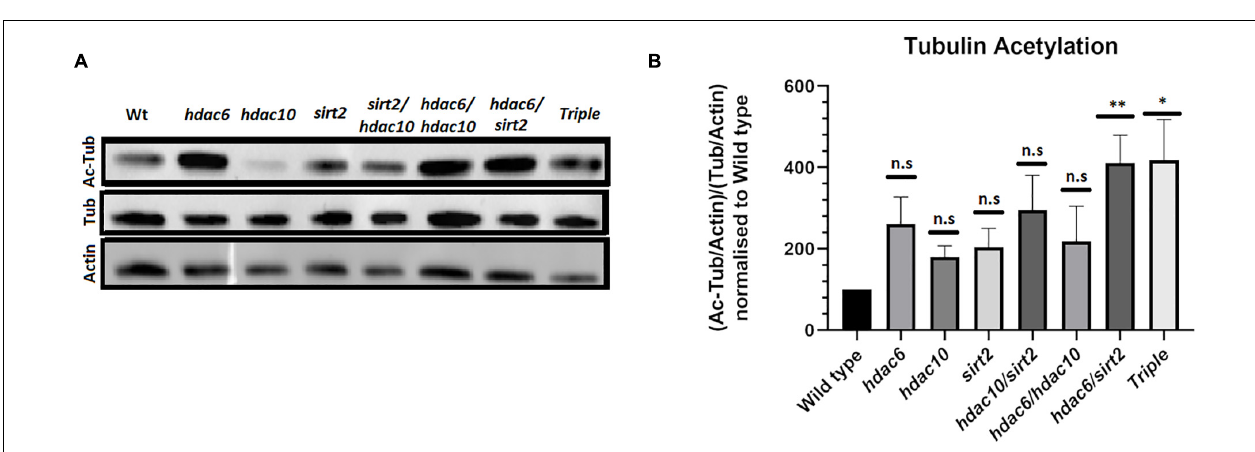
or hdac6 , and sirt2 ( Figure 3H ). As reliable antibodies against zebrafish hdac6 are not commercially available to confirm the role of Hdac6 in the observed phenotype we utilized a chemical